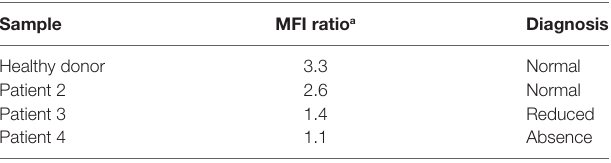
tABLe 1 | Mean fluorescence intensity (MFI) ratios of LRBA protein expression between patients with different LRBA